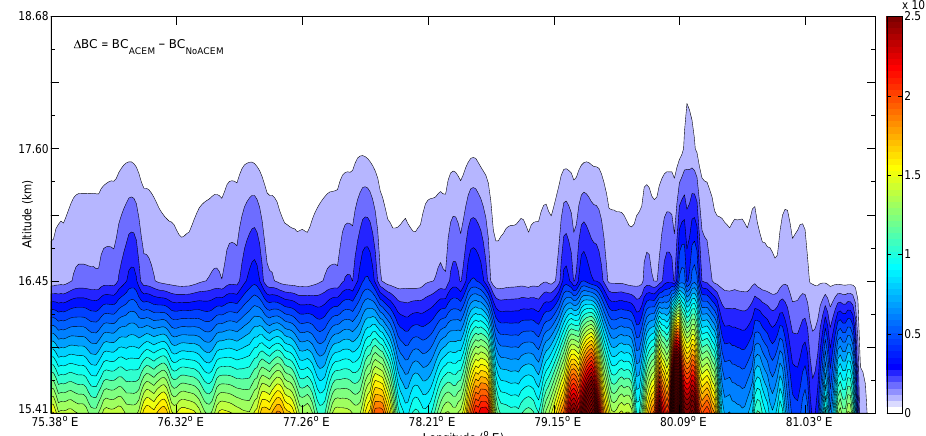
Figure 10. Vertical profile of the difference in BC mass concentration (µgm − 3 ) in ACEM runs vis-à-vis NoACEM runs averaged for the entire duration (1 week covering strong convective activity over the model domain) of the model simulations carried out during July 2010. Here, (cid:49) BC = BC ACEM − BC NoACEM